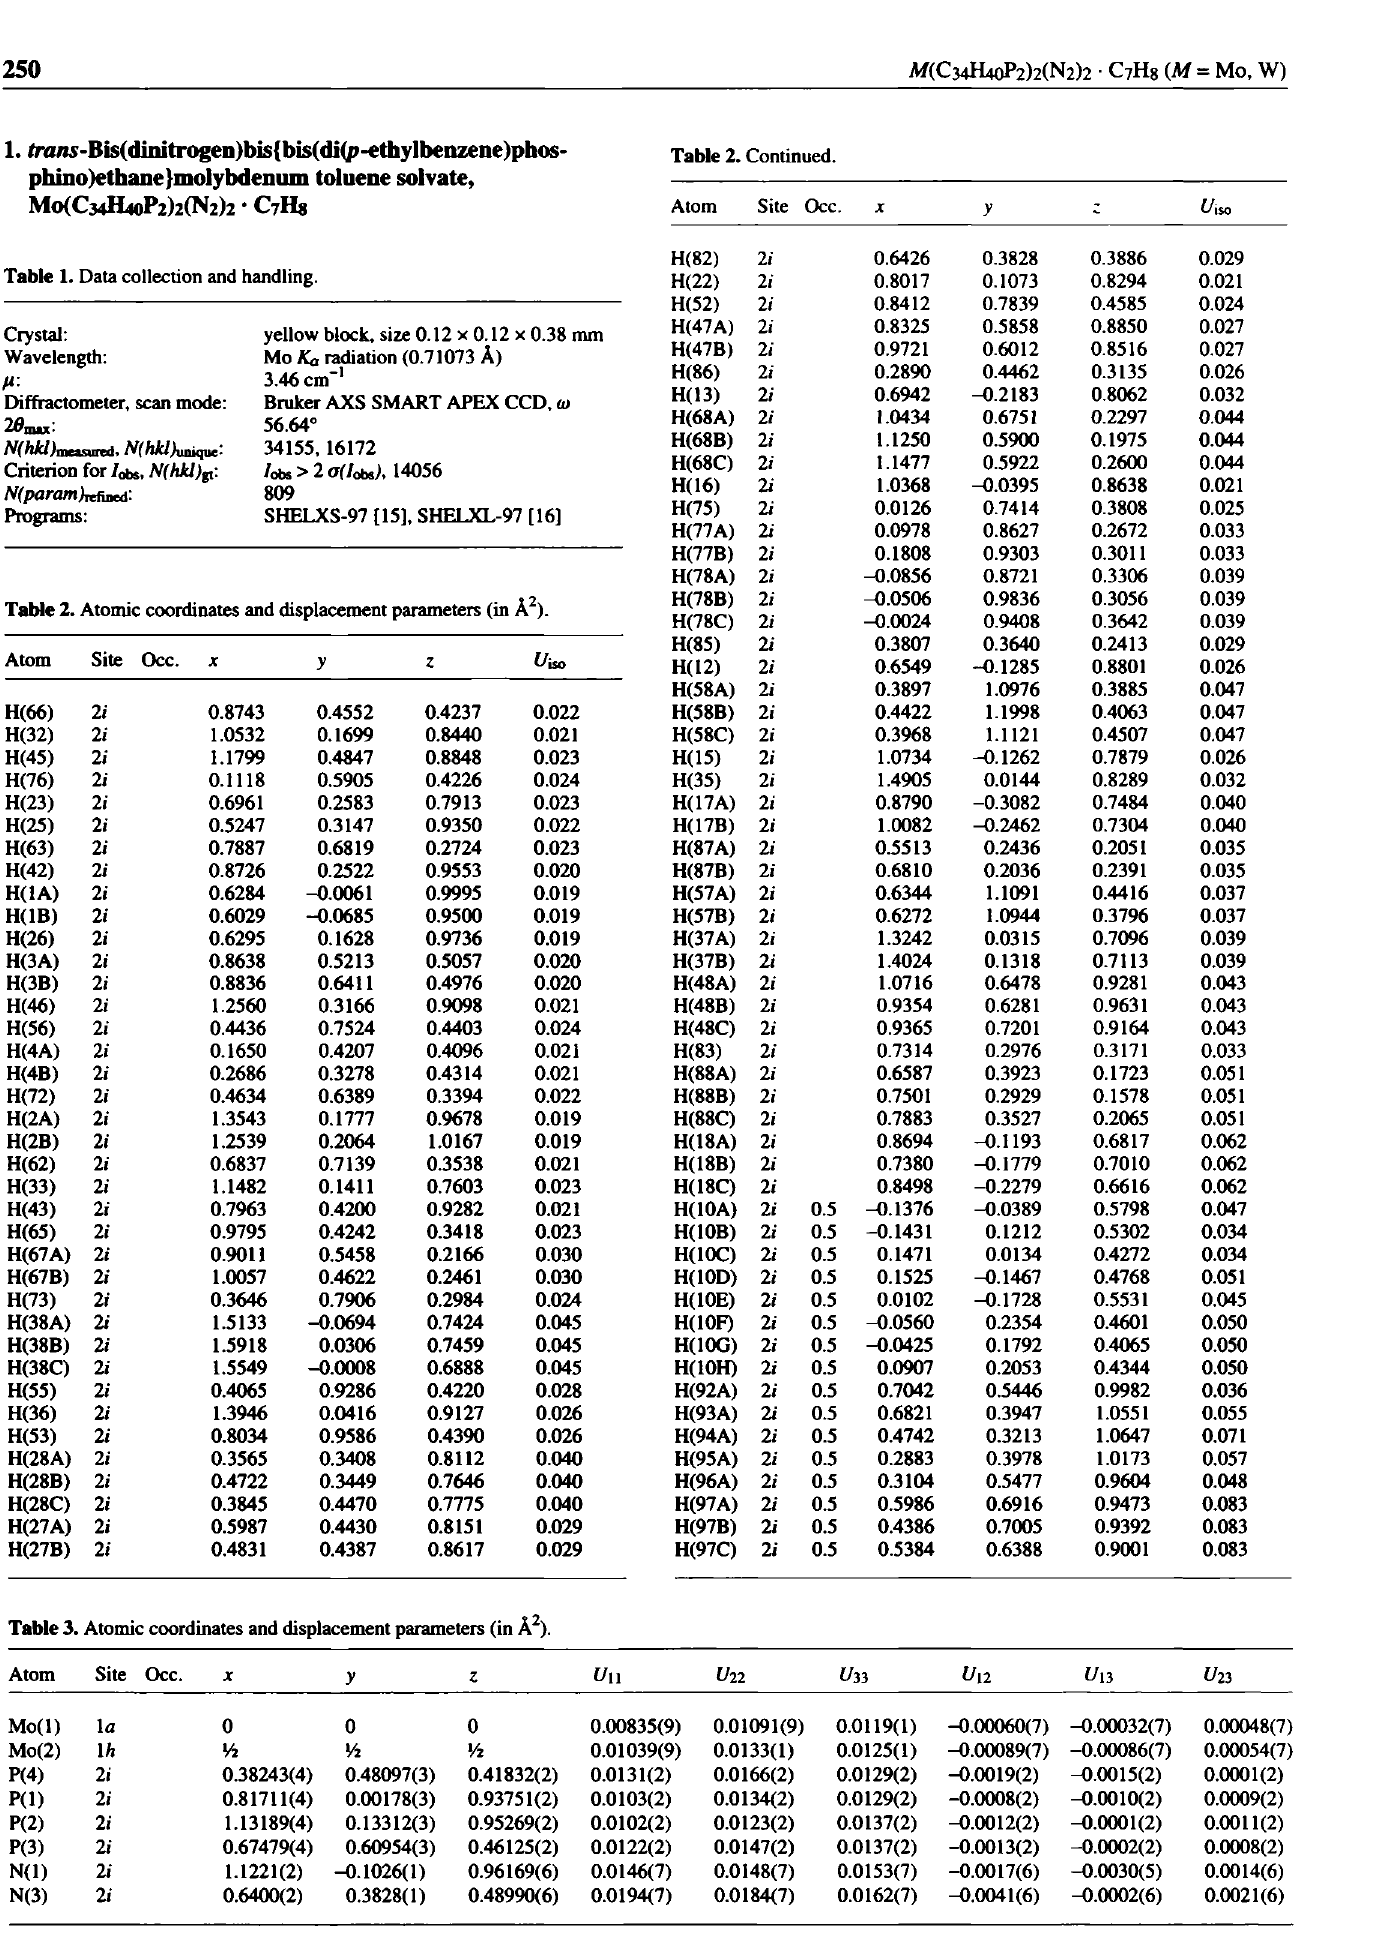
Table 1. Data collection and handling.